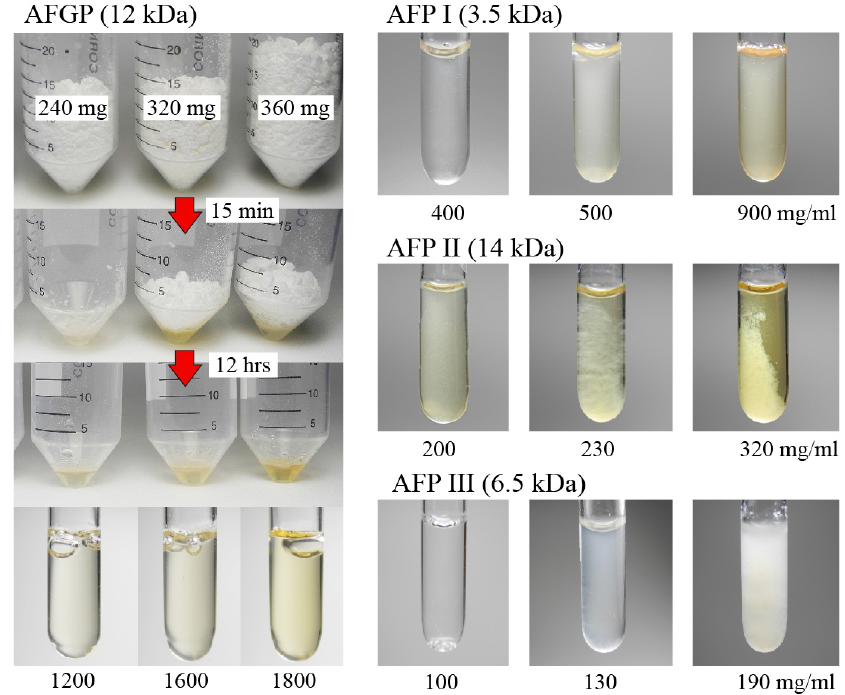
Figure 1. Solubility limit evaluation for native antifreeze proteins (AFP I–III) and antifreeze glycoprotein (AFGP) samples. For AFGP, 240, 320, and 360 mg each of the lyophilized powder was